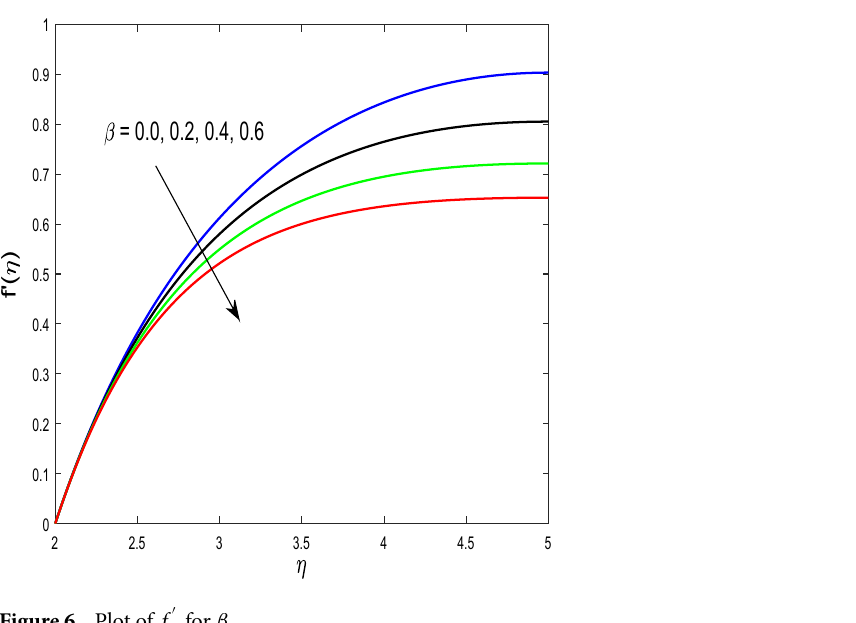
Figure 6. Plot of f ′ for β